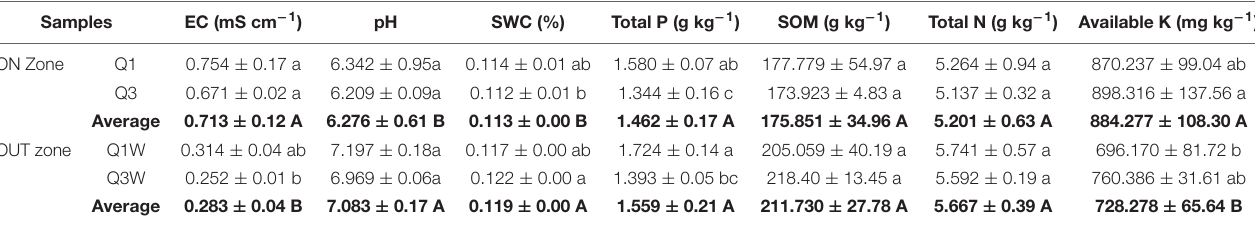
TABLE 2 | Soil physical and chemical properties of soil samples from the fairy ring of Leucocalocybe mongolica.